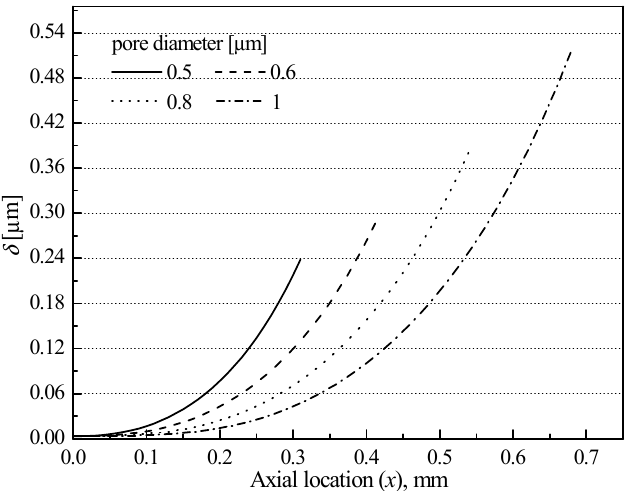
Figure 7. Liquid thin-film thickness for different pore diameters as function of axial location (see Figure 1).